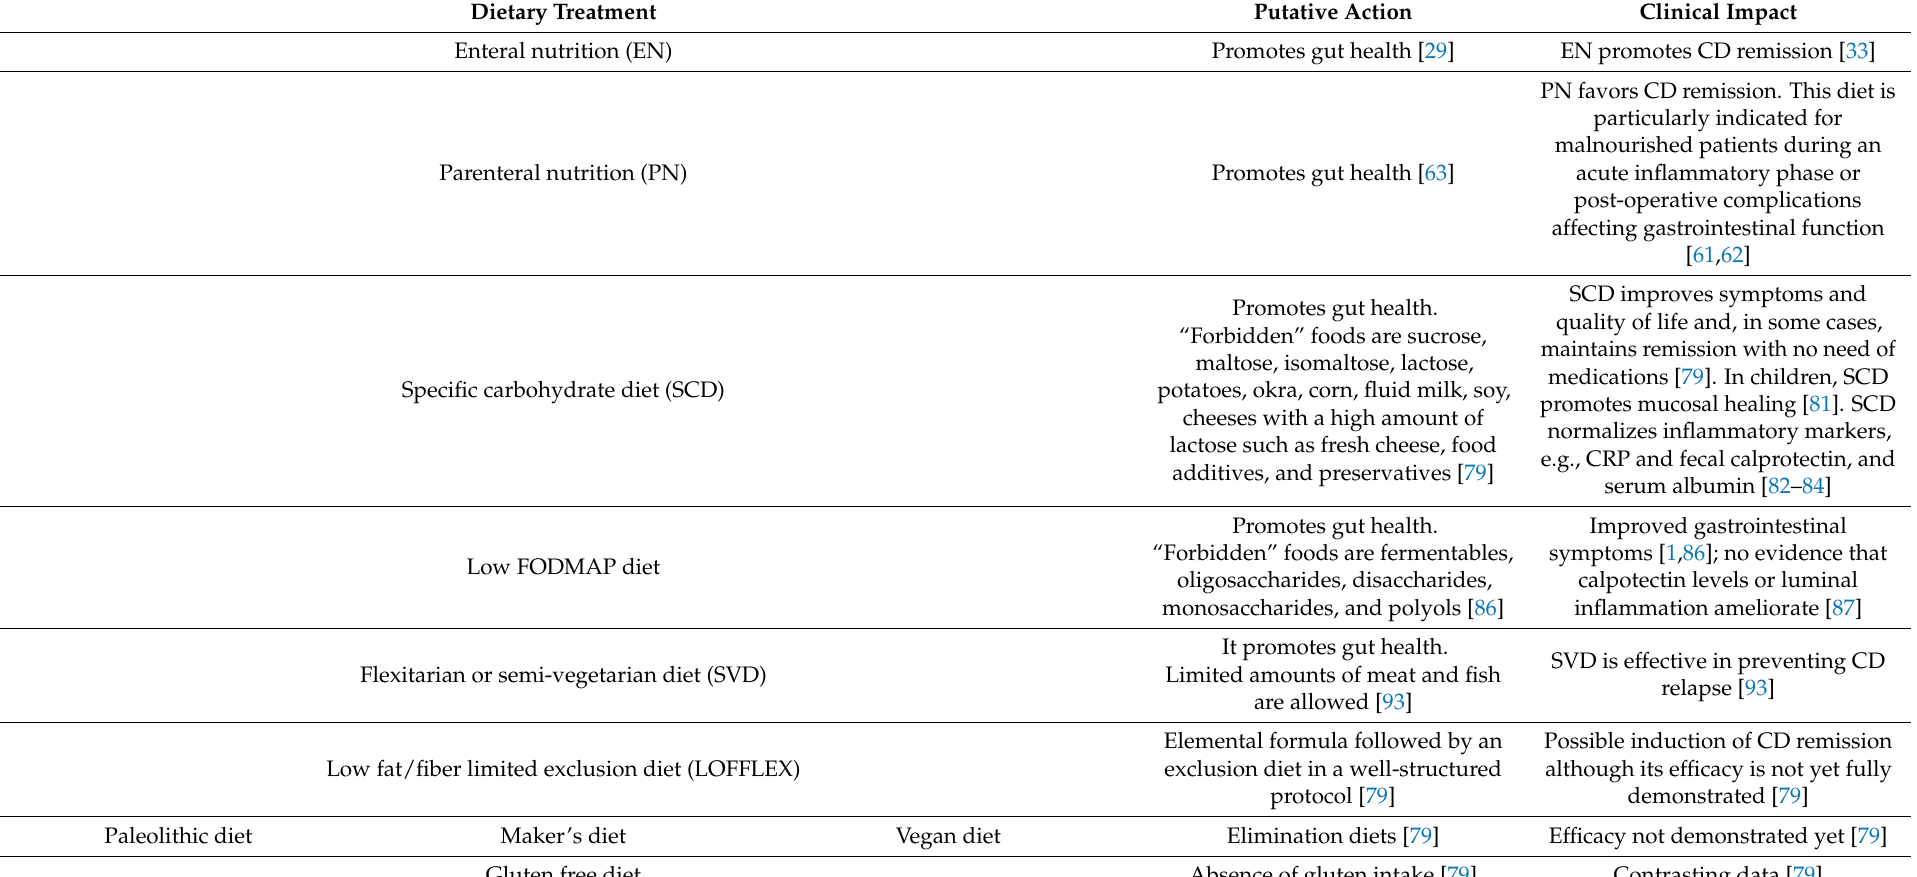
Table 1. Suggested dietary approaches for CD treatment with explanation of mechanisms of action and